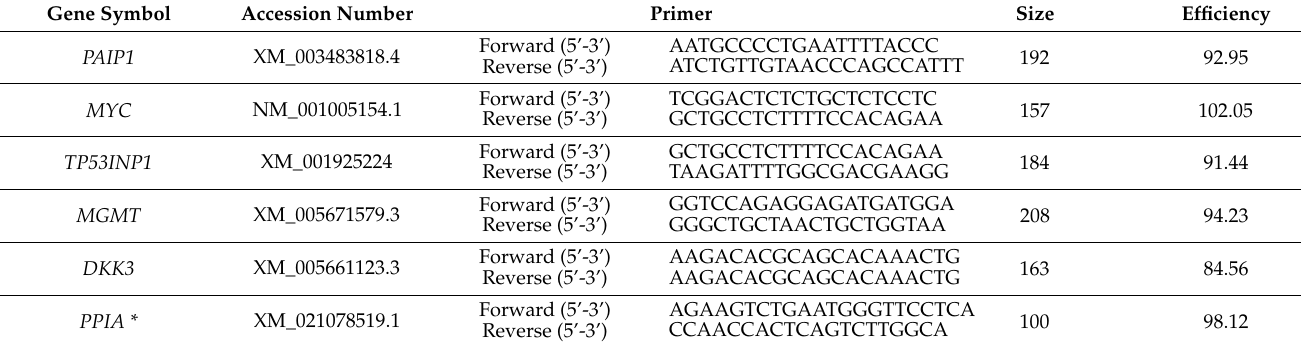
Table 4. Sequences of the primers used for the quantitative real-time PCR (RT-qPCR) analysis. Gene